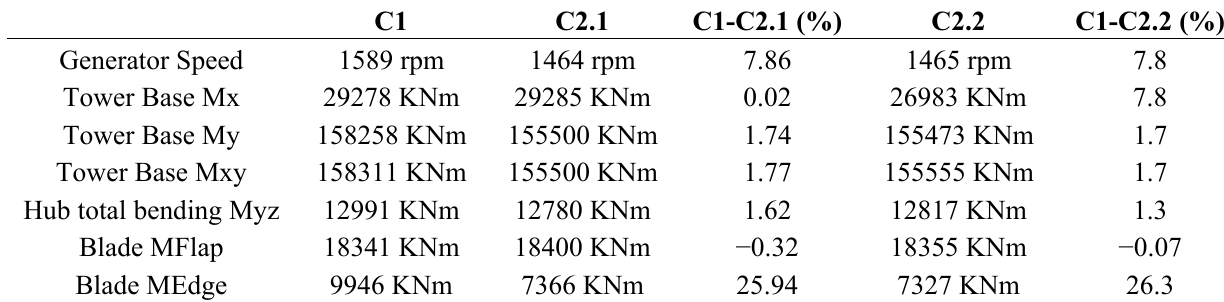
Table 5. Comparison of the extreme load